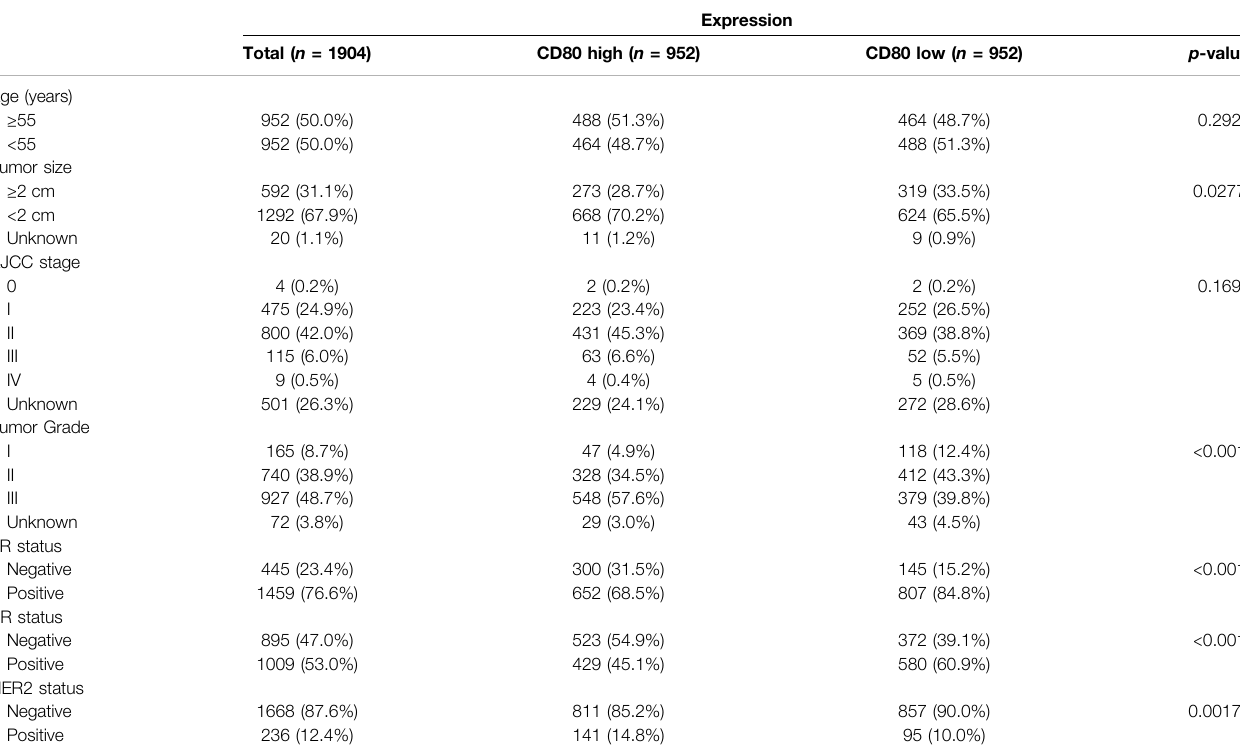
TABLE 2 | Association between the CD80 mRNA expression and clinicopathologic characteristics in the METABRIC cohort.